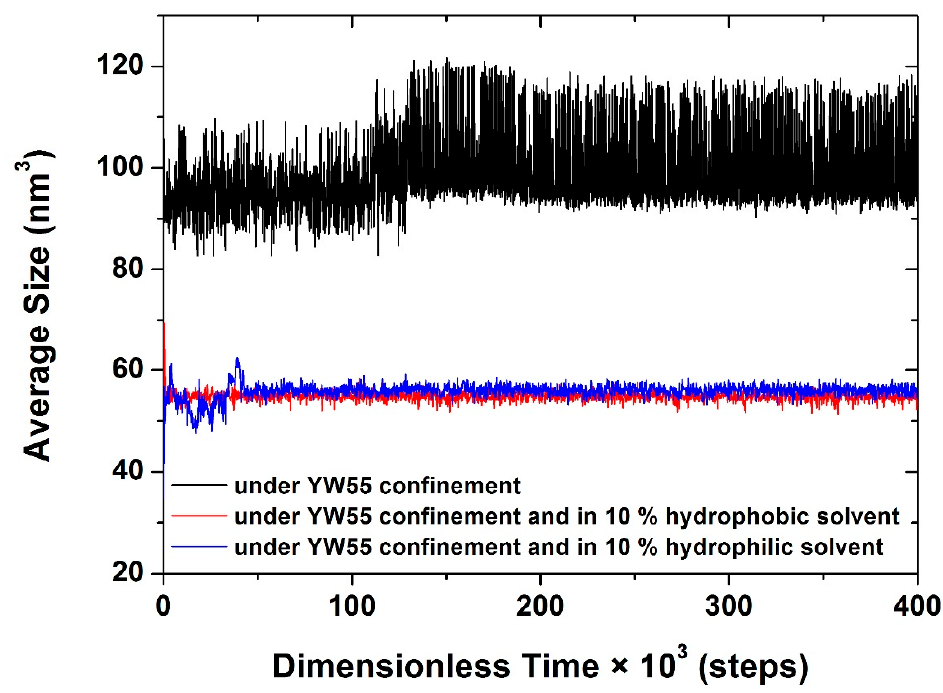
Figure 9. Average volumetric size of the self-assembled cylinders in three systems with time. They are the system under YW55 confinement denoted by the black line, the system under YW55 confinement and doped with 10% hydrophobic solvent denoted by the red line, and the system under YW55 confinement and doped with 10% hydrophilic solvent denoted by the blue line.